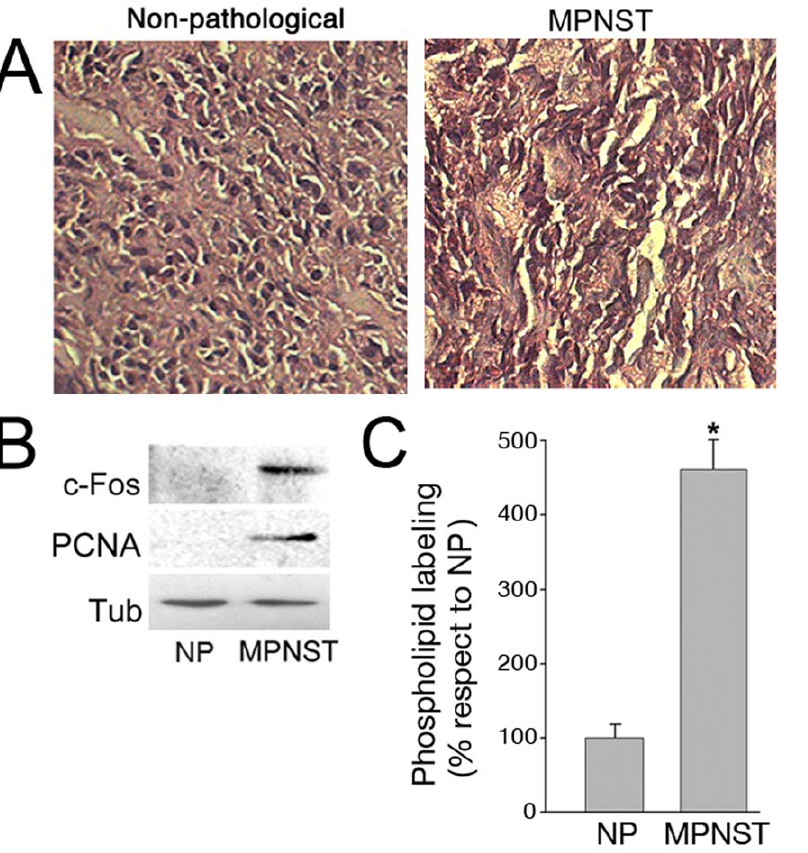
Figure 6. c-Fos expression is abundant and phospholipid synthesis is activated in a MPNST from a patient with NF1 syndrome. ( A ) Histological examination of a MPNST and a non-pathological specimen excised from an NF1patient, stained with haematoxylin/eosin. Note the neoplastic cells in the MPNST contrasting with the non-pathological (NP) tissue. ( B ) WB for c-Fos and PCNA of the samples shown in (A). Note the lack of c-Fos and PCNA expression in the normal tissue (NP). Tubulin was used as a loading control. ( C ) Phospholipid synthesis capacity in TH from the MPNST and the NP sample. Results are the mean % 6 SD of 2 experiments performed in triplicate. TH values from NP were taken as 100%. Phospholipid synthesis activity in the MPNST was . 4-fold that in NP; *p ,